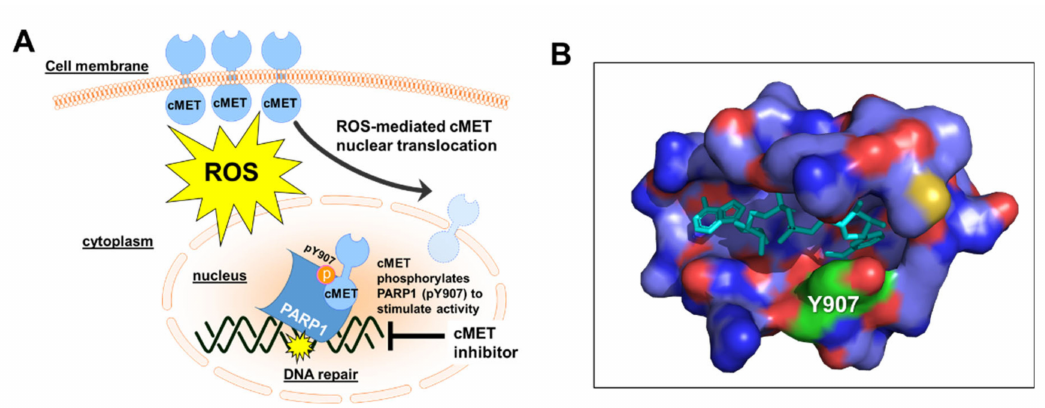
Figure 4. Attenuation of PARP Activity by cMET inhibition. ( A ) cMET enhances PARP activity during oxidative stress. Inhibition of cMET is an excellent strategy for inhibiting PARP1-mediated DNA repair and synergy with PARP inhibitors. ( B ) A snapshot of non-hydrolyzable NAD + analog (in cyan) bound to residues in PARP1 catalytic active site within 6Å from the ligand (PDB ID: 6 bhv, processed via PyMOL Molecular Graphics System). Phosphorylation of PARP1 residue Y907 (shown in green) inhibits binding of PARP